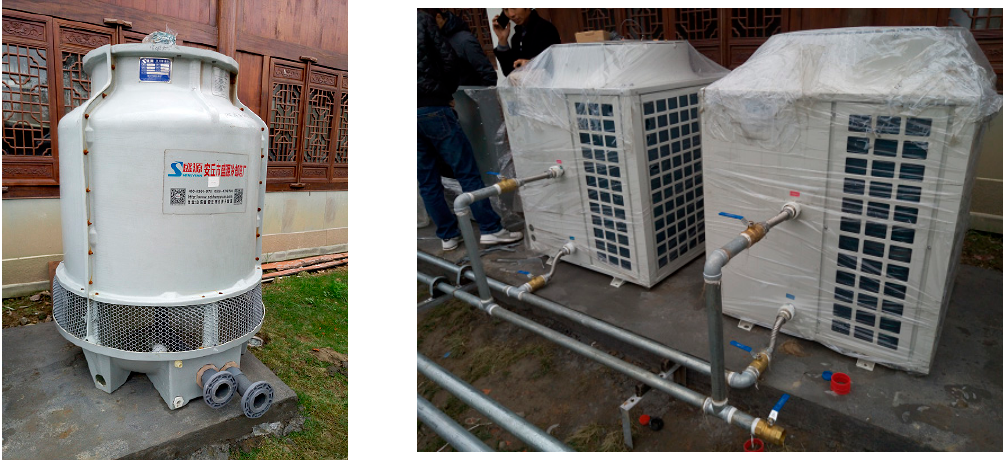
Figure 6. Photos of the (left) cooling tower and the (right) two heat pumps.